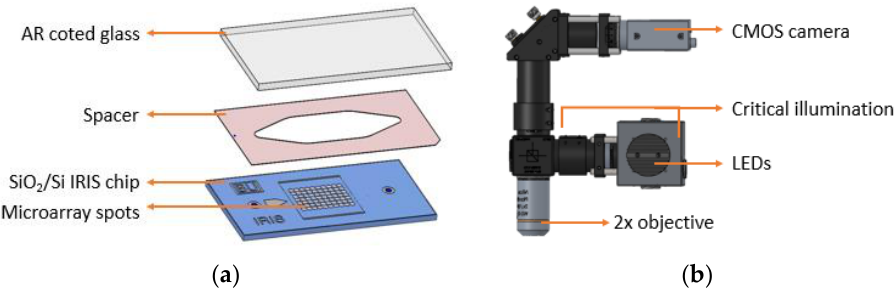
Figure 1. ( a ) The Reflectance Imaging Sensor (IRIS) fluidic cartridge; ( b ) the IRIS optical setup.